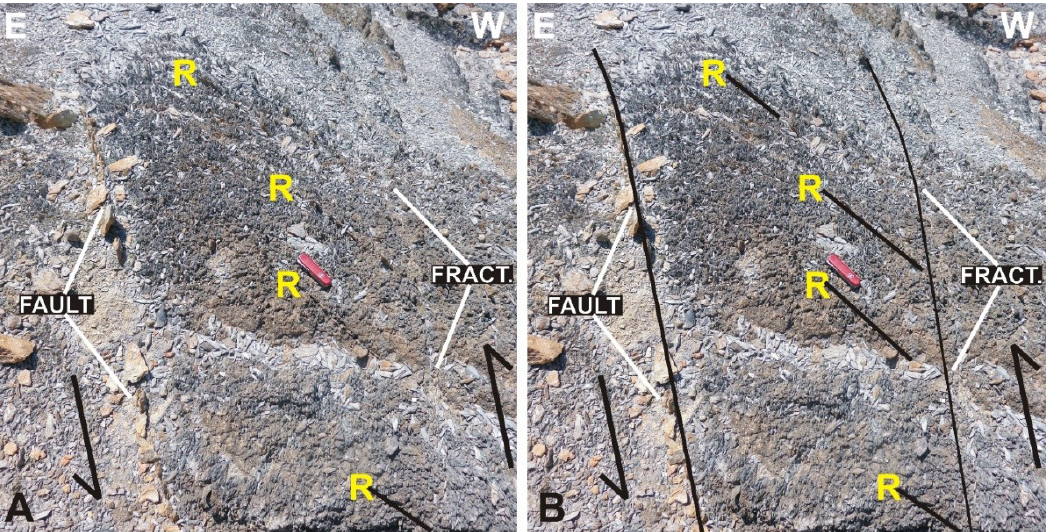
Figure 10. Boudin associated with Riedel shear (left of the hammer). The Riedel shear indicates top- Table 11. Sinistral calcite-filled fracture system with a minor fault (left) and a parallel fracture (right). Between the fault and the fracture is a parallel array of widened, right-stepping Riedel shears (marked by “R”). The red pocket knife for scale is positioned parallelly to the calcite shear veins. A ) Natural appearance of structures. B ) Fractures marked by black lines for easier perception.